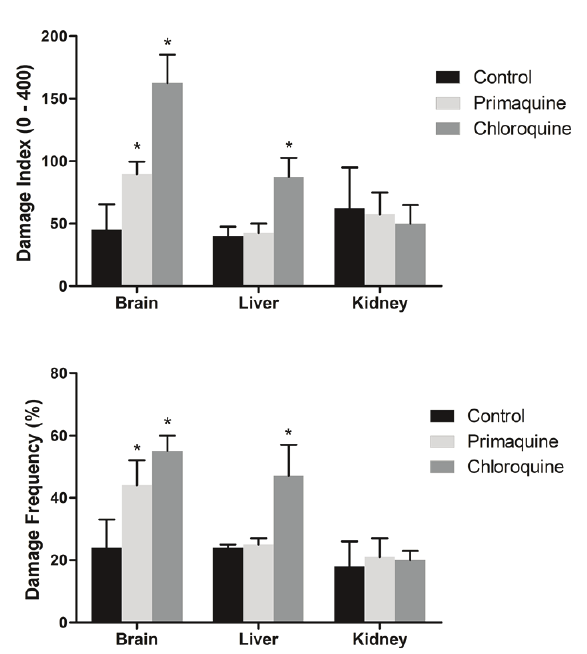
Figure 3 - Effect of 21 days of administration of primaquine and chloroquine on frequency and index of DNA damage in brain, liver and kidney of rats (n = 7 per group). Data were analyzed by one-way analysis of variances followed by the Tukey test when F was significant. Values are expressed as mean ± S.D. *p < 0.05 compared to control